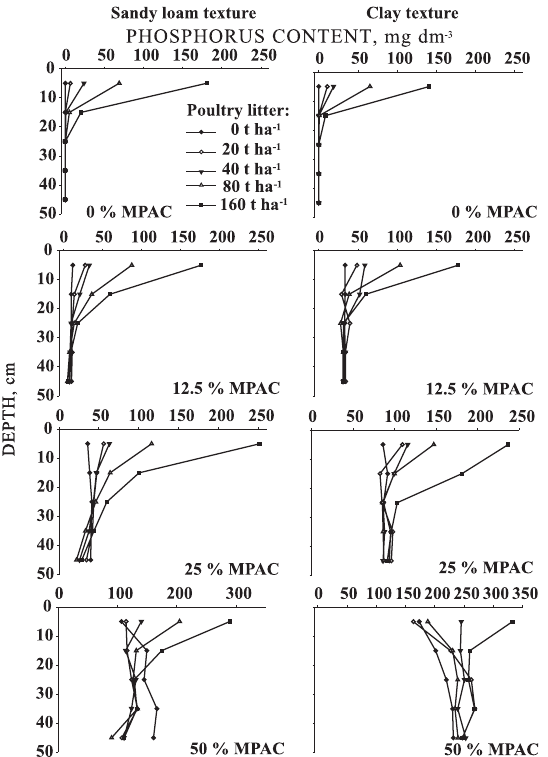
Figure 3. Phosphorus contents by Mehlich-1 (Pm) in samples of two Latosols with sandy loam and clay texture, prefertilized with increasing mineral P rates corresponding to the percentages of Maximum Phosphorus Adsorption Capacity (MPAC), as related to the poultry litter rates applied in the top